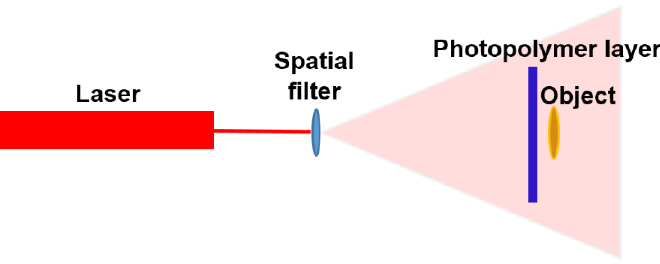
Figure 5. Principle of operation of a holographic pressure sensor.